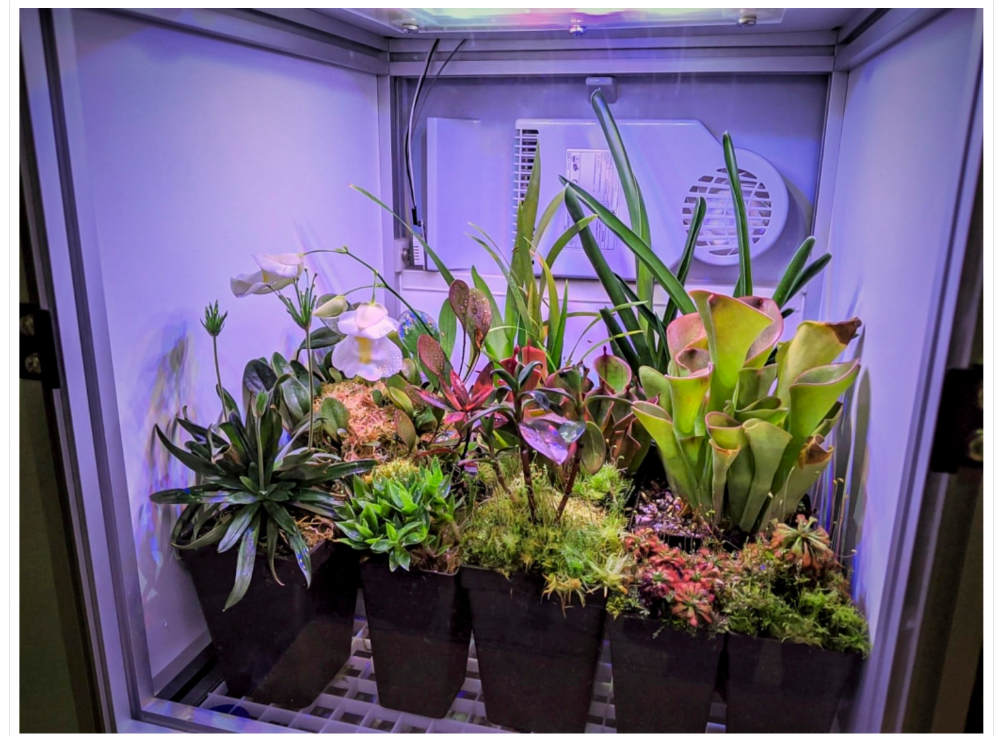
Figure 16. Plants growing in the chamber. Note the presence of inflorescence on Utricularia alpina and Paepalanthus sp.